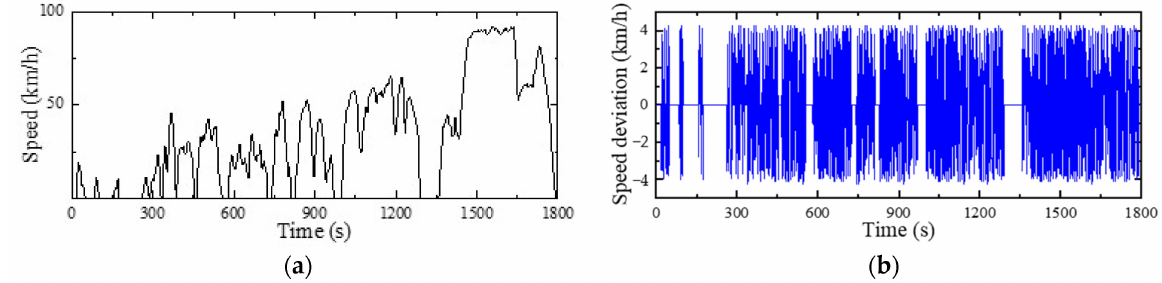
Figure 8. Driving cycle of the experimental test. ( a ) Speed curve of CLTC-C standard; ( b ) speed deviation during the test of